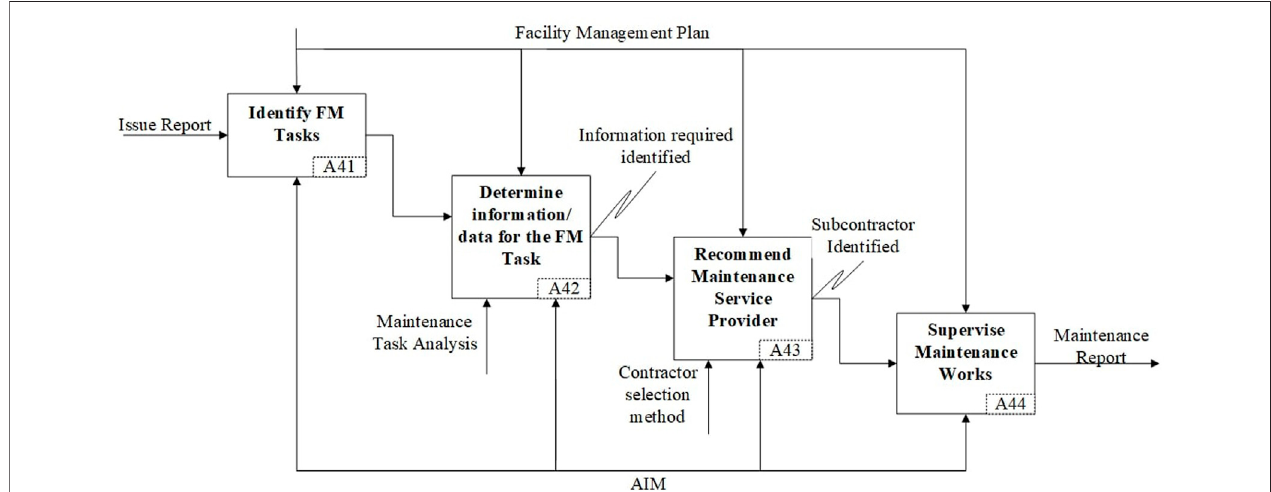
FIGURE 7 | Process model of Implement Operation and Maintenance